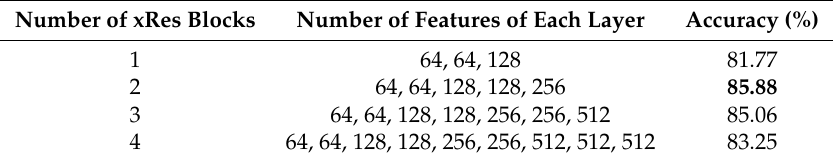
Table 2. Comparison of different numbers of ML-xRes blocks of ML-xResNet in accuracy, the best result is in